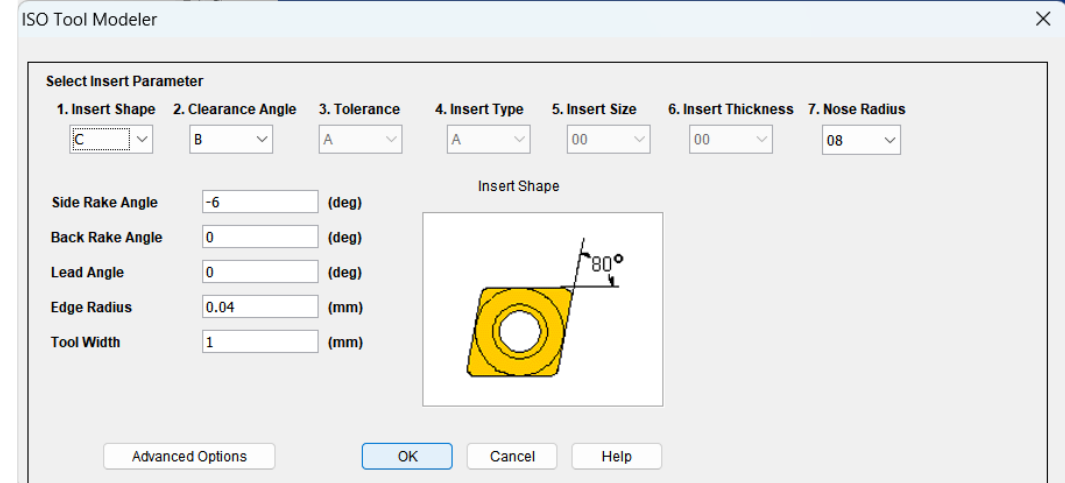
Figure 4. The cutting tool parameters.